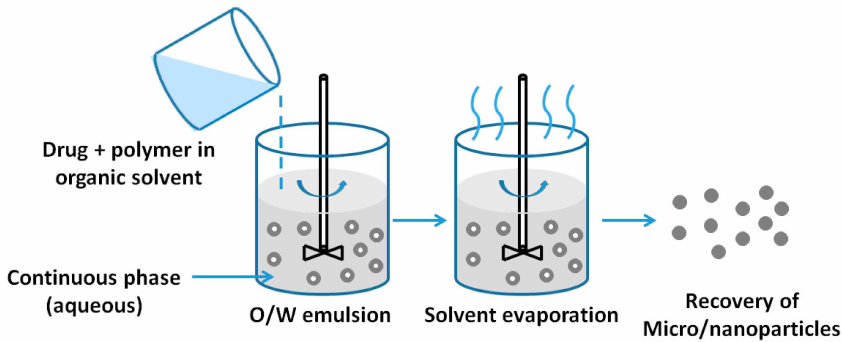
Figure 4. Preparation of NPs by emulsion evaporation